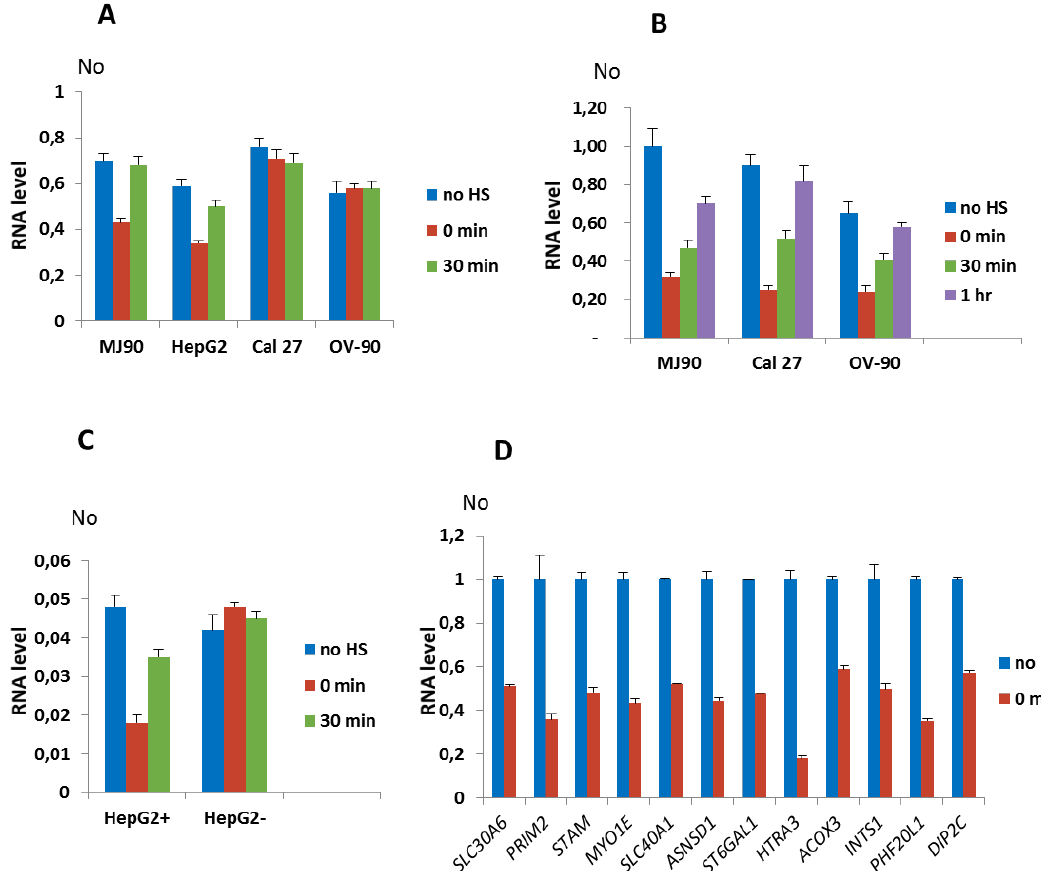
Figure 3. Dynamics of expression of genes associated with dispersed alpha satellite repeats after HS. Expression of: ( A ) ZNF675 associated with polymorphic alpha satellite repeat 29 which is present in cell lines MJ90 hTERT and HepG2, and absent in Cal 27 and OV-90, under standard conditions (no HS), immediately after 2 h of HS (0 min) and 30 min of recovery, ( B ) NR3C1 in cell lines MJ90 hTERT, Cal 27 and OV-90 where alpha repeat 10 is present on both alleles, and ( C ) NR3C1 allele specific expression in HepG2 cells from the allele with (HepG2 + ) and without (HepG2-) alpha repeat 10, under standard conditions (no HS), after 2 h of heat stress (0 min), and at 30 min and 1 h of recovery, ( D ) SLC30A6, PRIM2, STAM, and MYO1E with alpha repeats in intron and SLC40A1, ASNSD1, ST6GAL1, HTRA3, ACOX3, INTS1, PHF20L1, DIP2C associated with intergenic alpha repeats. Expression is analyzed in MJ90 hTERT cell line under standard conditions (no HS) and immediately after 2 h of HS (0 min). In ( A – C ) No represents normalized average No value for each gene. In ( D ) relative No values are shown that are obtained by dividing each No value by No value of control (no HS), for each gene. Columns show average of two di ff erent RT-qPCR experiments performed in triplicate and error bars represent standard deviations.